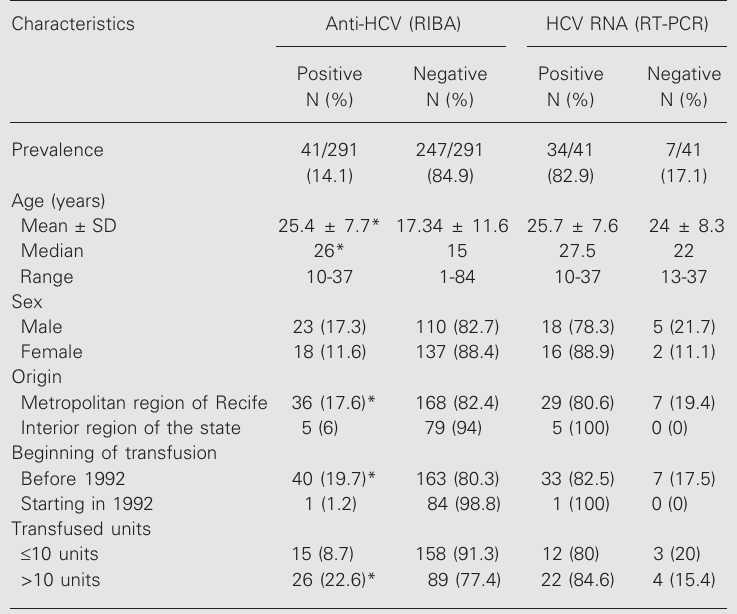
Table 1. Distribution of patients with sickle-cell anemia studied from January to December 1998 at the Hospital of the HEMOPE Foundation according to demographic and clinical characteristics and to the result of anti-HCV antibody (RIBA) and HCV RNA